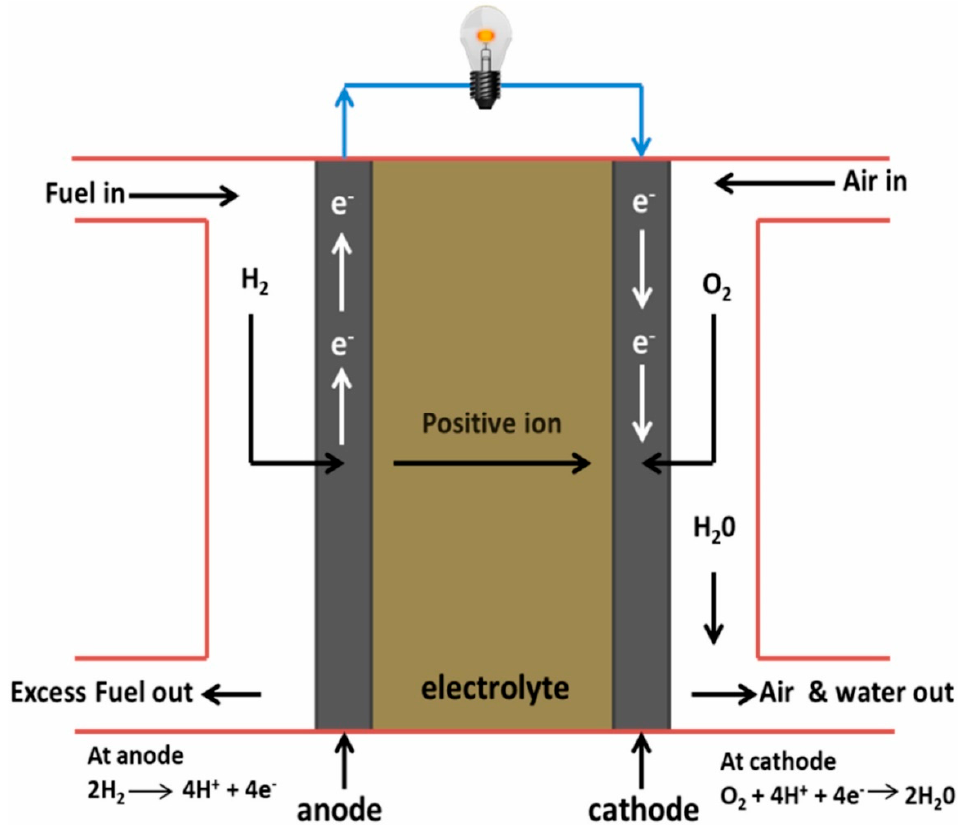
Figure 8. FC general diagram [68]. Republished with permission from Elsevier (License no: 5398681399569) 3.1. Types of Fuel Cells.